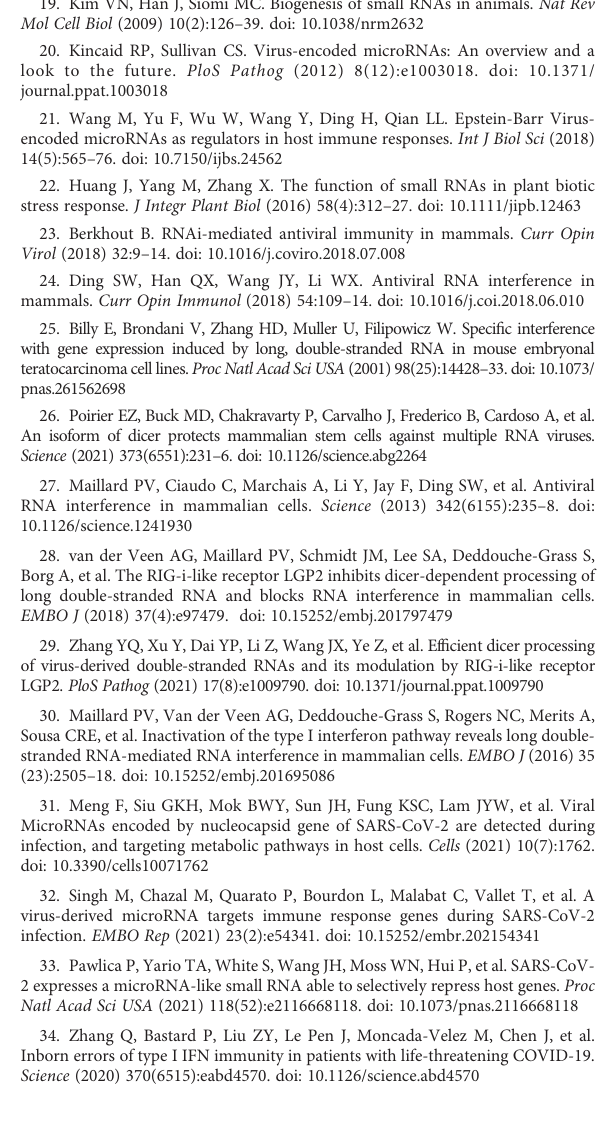
with A/U/C/G at positive and negative strands. (B) Size distribution and abundance of 18-35 nt vsRNAs in SARS-CoV-2 infected A549-hACE2 cells Gatnegativestrand. (C) Sizedistributionandabundanceof18-35ntvsRNAs in SARS-CoV-2 infected Calu-3 at 4, 12, 24 hpi from Wyler et al., 2021. Pie CoV-2 infected Calu-3 at 24, 36 and 48 hpi from Kim et al., 2021. Pie plots represent vsRNAs initiated with A/U/C/G in positive and negative strands. SUPPLEMENTARY FIGURE 5 SINVformscontinuous20-ntperfectcomplementarybasepairswith2-nt 3 ’ overhang. Read sequences along the 5 ’ -terminal 120 nt sequence of SINV genome. Read counts (in brackets), read length and genomic position are indicated and mismatched bases are mentioned in